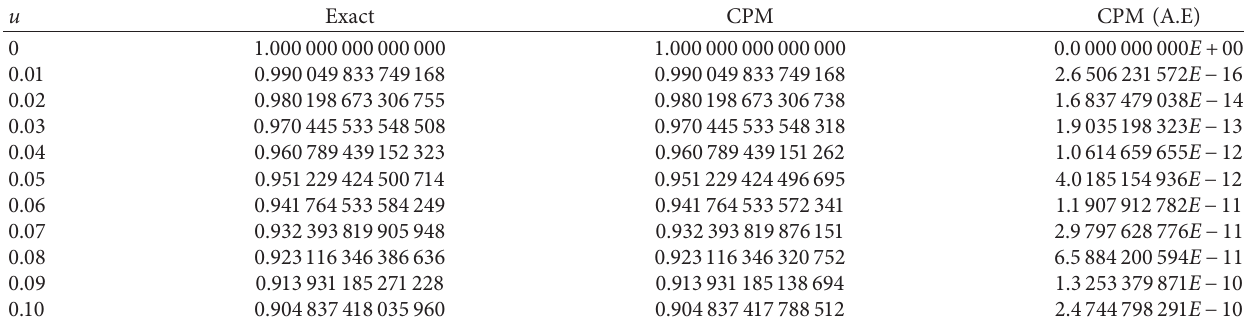
Table 9: Exact, CPM solution, and CPM error of problem 5 for m �